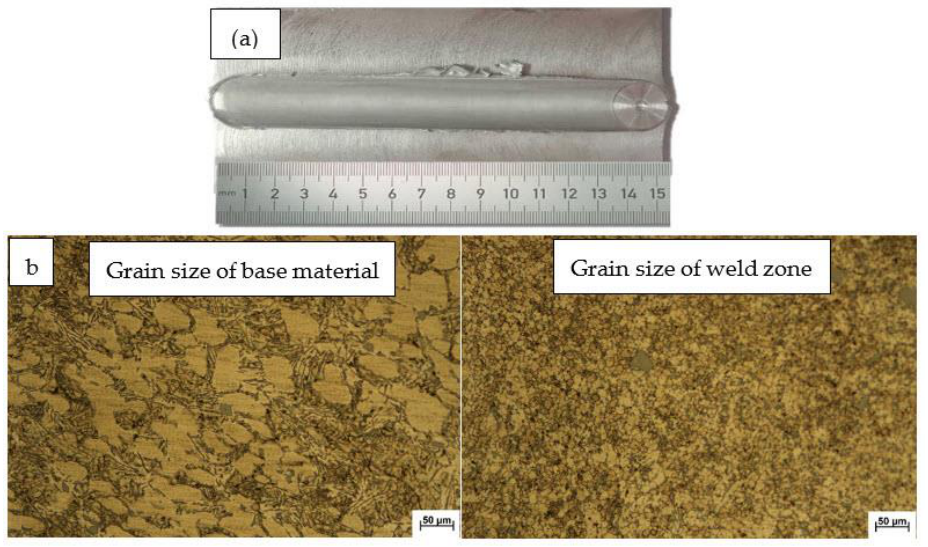
Figure 8. Weld seam of MOVaNSAS: ( a ) weld seam surface suggestion; ( b ) grain size comparison with base material and weld zone.